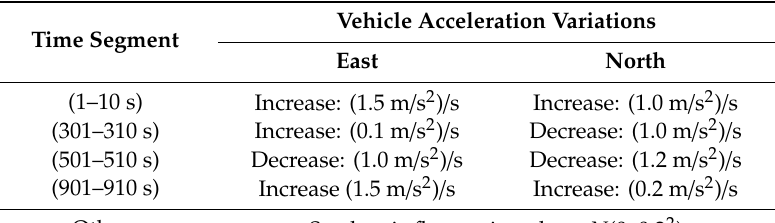
Table 1. Vehicle acceleration variations.